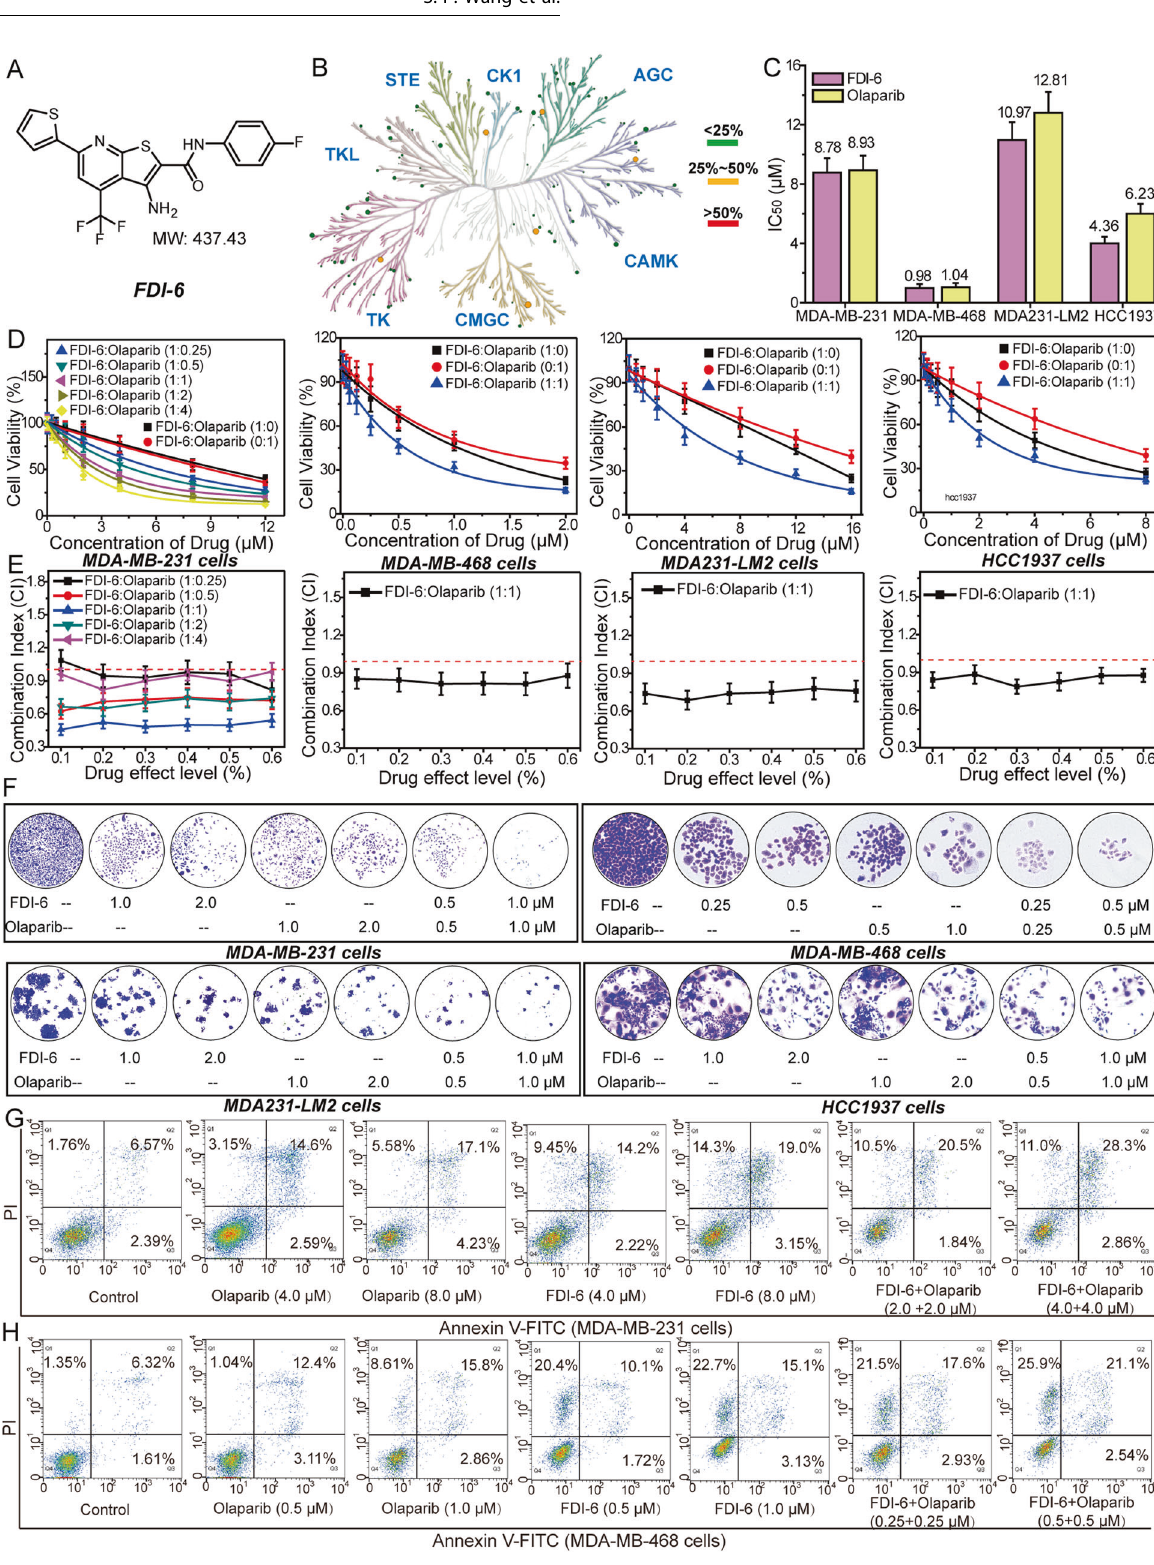
Cell Death and Disease (2021)